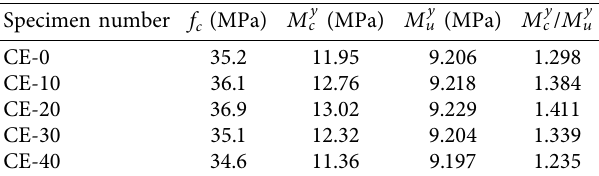
Table 4: Comparison of experimental and computational results according to formulas (1) and